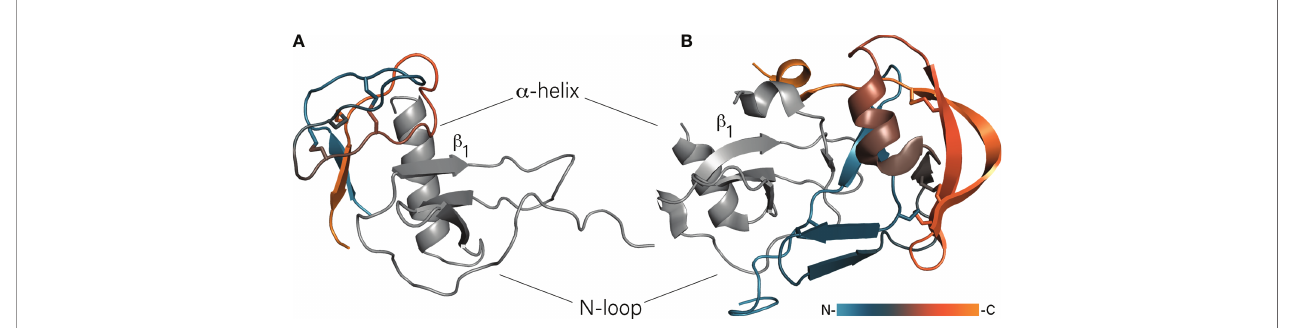
FIGURE 1 | Binding of chemokines by class A and B evasins. (A) The model of EVA-3/CXCL8 complex. Unstructured N - and C -termini of EVA-3 are hidden for visibility. (B) The crystal structure of EVA-1/CCL3 complex (PDB: 3FPU). Evasins are colored according to a gradient from N - to C -terminus, chemokines are shown in grey and oriented in the